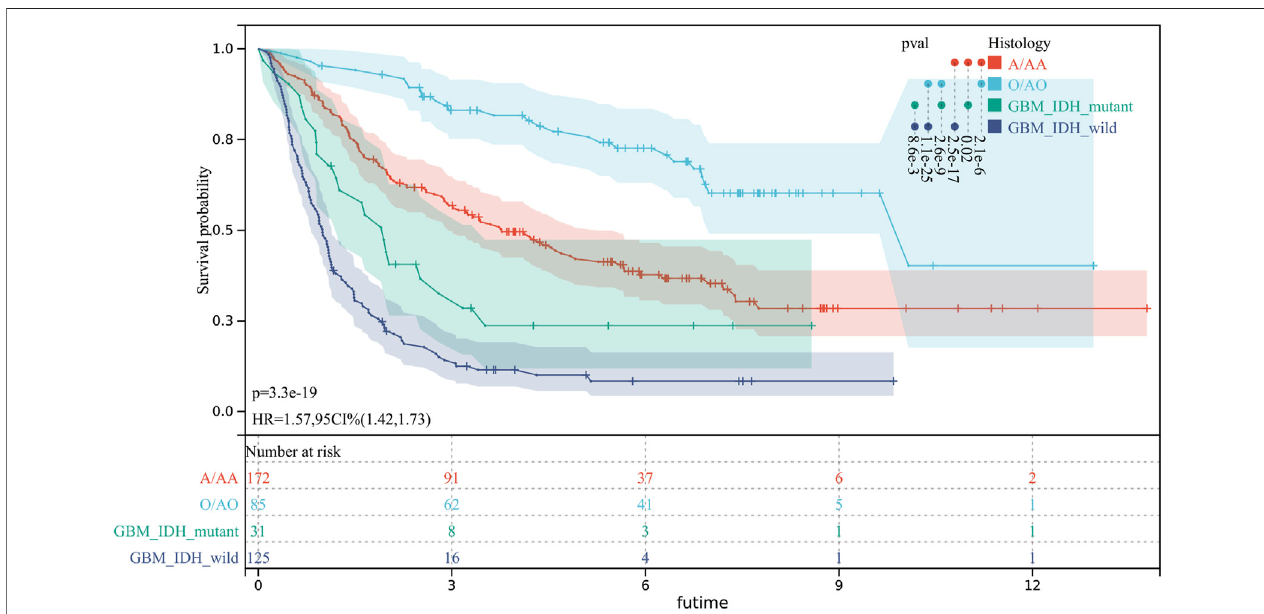
FIGURE7| Prognosticdifferencesin4gliomasubgroups.GBMIDHwildtype;GBMIDHmutant;O/AO(OligodendrogliomaII/AnaplasticoligodendrocytomaIII);A/ AA (Astrocytoma II/Anaplastic astrocytoma III).